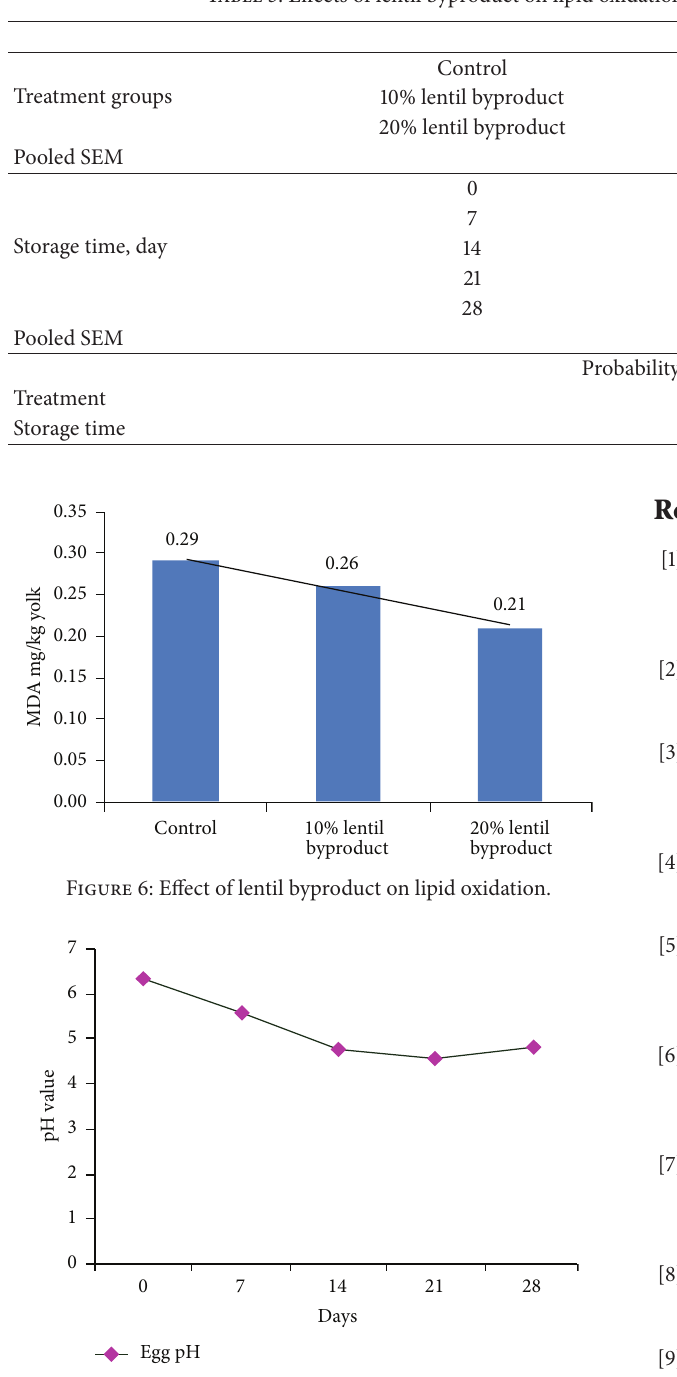
Table 5: Effects of lentil byproduct on lipid oxidation (mg MDA/kg yolk) and pH of quail eggs.